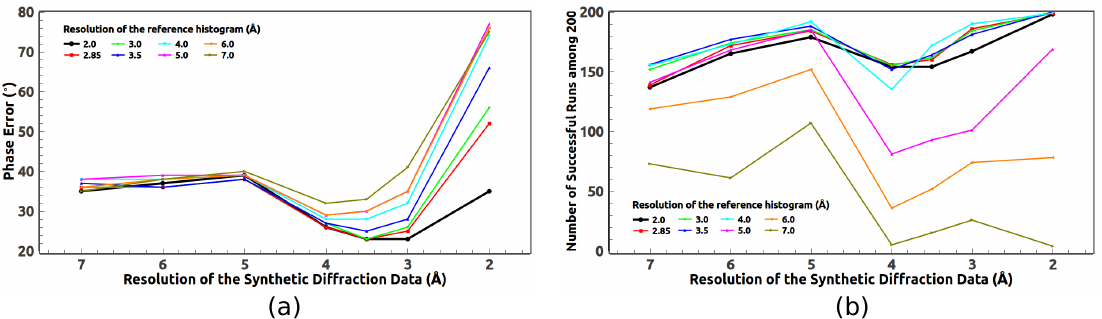
Figure 13. ( a ) The phase error and ( b ) the number of successful runs of 2JLN when the reference histograms in Figure 11 are tested on the synthetic data at various